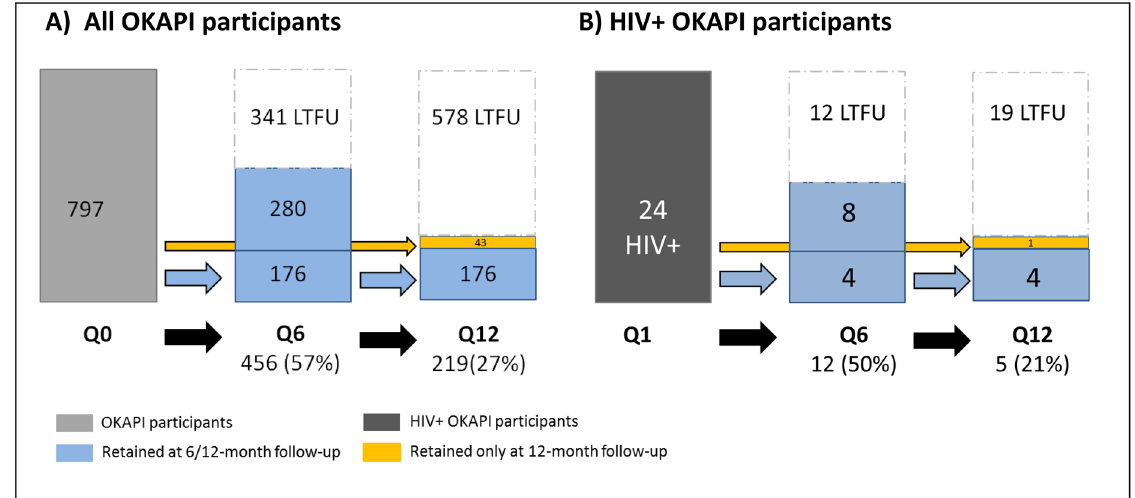
Figure 1. Follow-up diagram. Q0: baseline questionnaire; Q6: 6-month follow up questionnaire; Q12: 12-month follow up questionnaire; LTFU: lost-to-follow